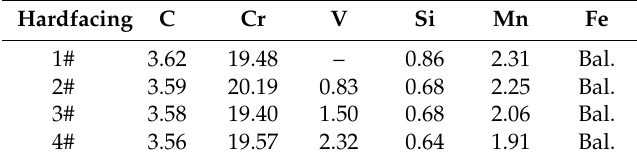
Table 2. Chemical compositions of high chromium cast iron hardfacing layer wt